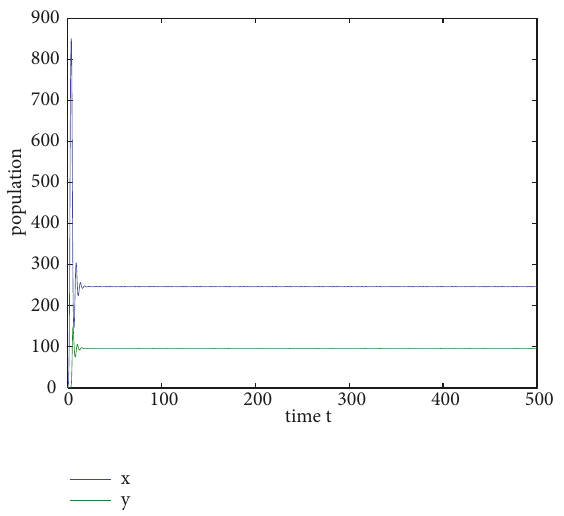
Figure 6: A Time series diagram for prey and predator. The figure depicts local stability of the interior equilibrium for the model (2), where the parameter values are 𝑥(0) = 230 , 𝑦(0) = 95 , 𝐴 = 0.01 , 𝑟 = 2.65 , 𝐾 = 900 , 𝑎 = 0.02 , 𝑐 = 0.215 , and 𝑚 = 1.06 .